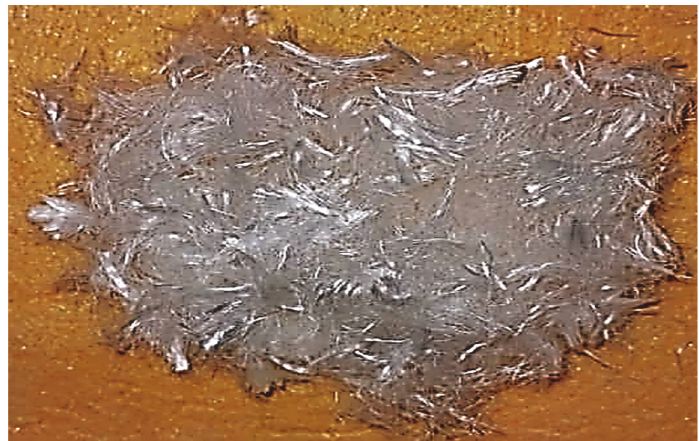
Figure 2: Polypropylene